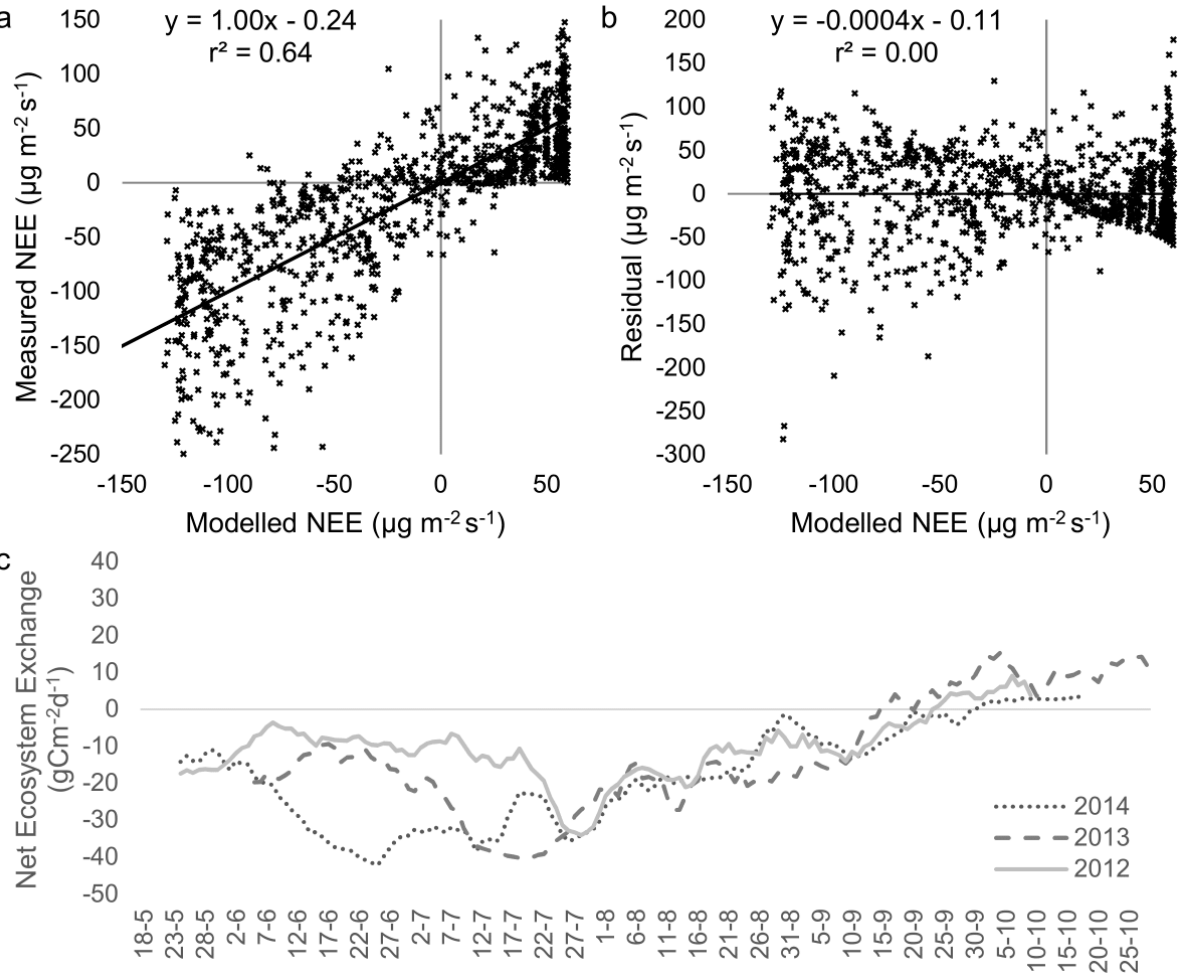
Figure 8. (a) Measured net ecosystem exchange (NEE) in carbon equivalents (μg m -2 s -1 ) against modelled NEE in carbon equivalents (μg m -2 s -1 ) using Equation 3. (b) Model residuals in carbon equivalents (μg m -2 s 1 ) against modelled NEE in carbon equivalents (μg m -2 s -1 ). (c) Weekly average NEE in carbon